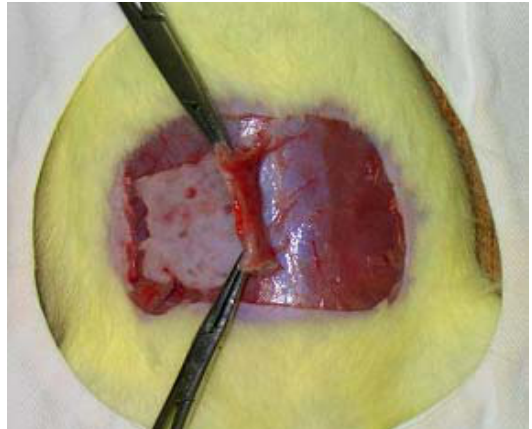
FIGURE 2: Dissection of flap contralaterally to pedicle up to Linea Alba.